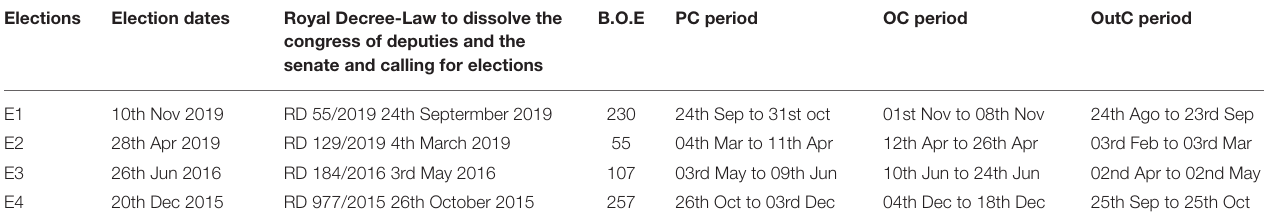
TABLE 3 | Campaigns corresponding to the Spanish General Elections under study.